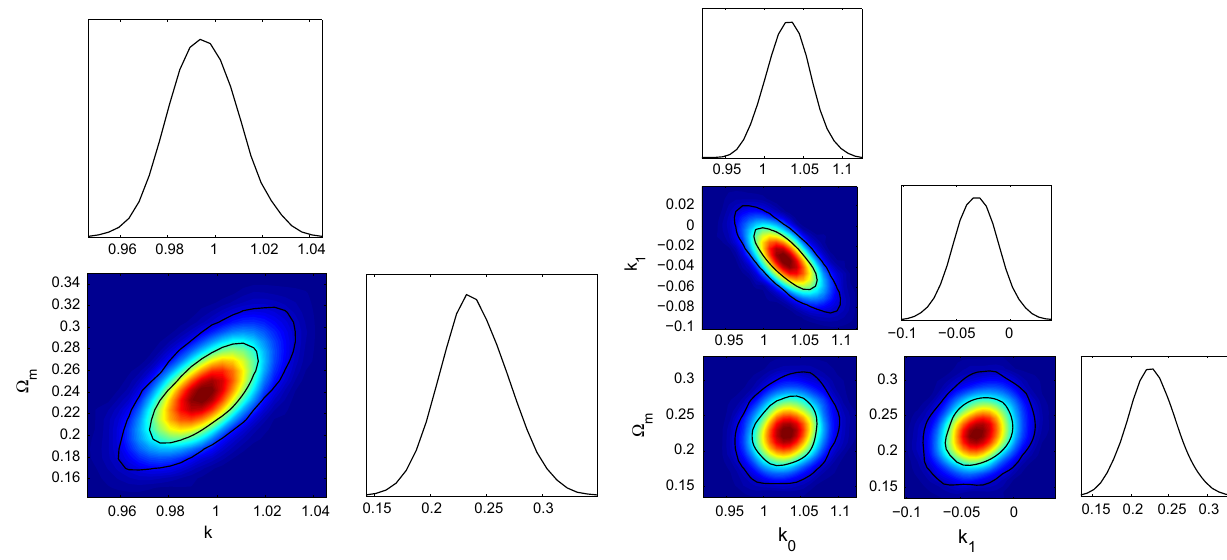
Fig. 5 Normalized posterior likelihood of (cid:2) m in the flat (cid:3) CDM model with Hubble constant from Riess (2016)